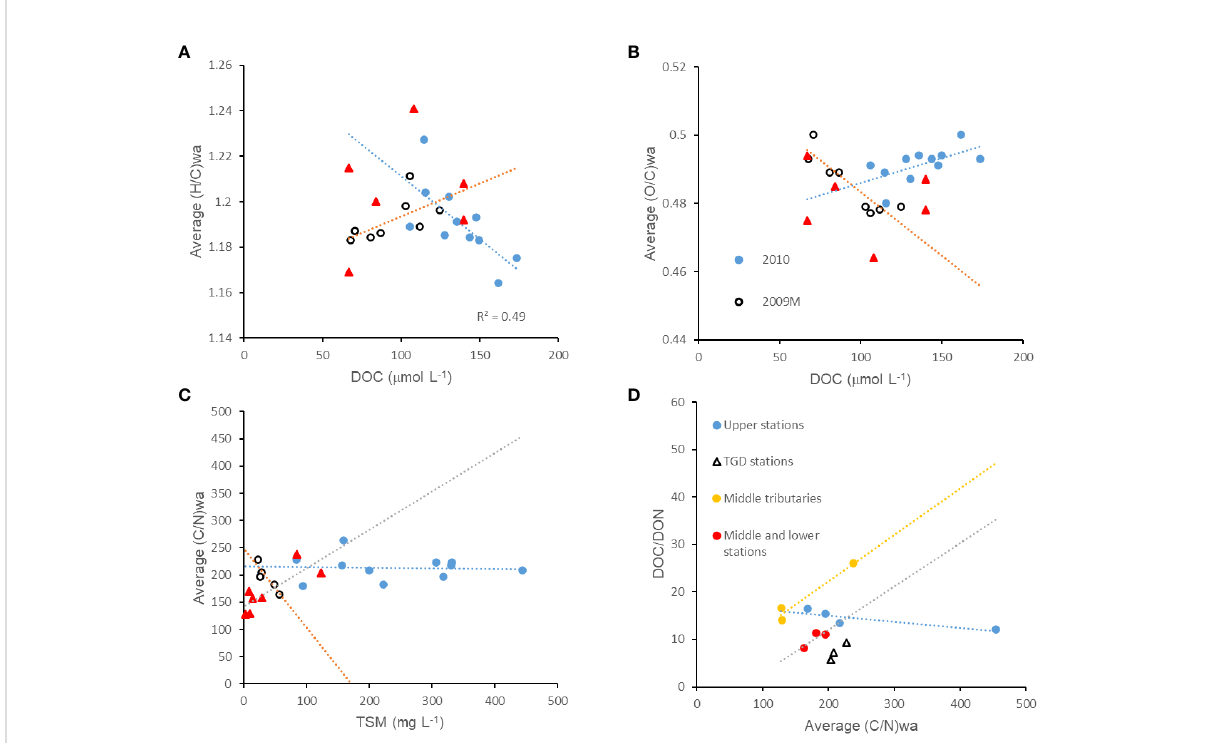
FIGURE 5 Linear correlations of bulk parameters with elemental proxies subdivided into various sample groups. (A) : DOC vs (H/C) wa ; (B) : DOC vs (O/C) wa ; (C) : TSM vs (C/N) wa ; (D) : DOC/DON vs (C/N) wa